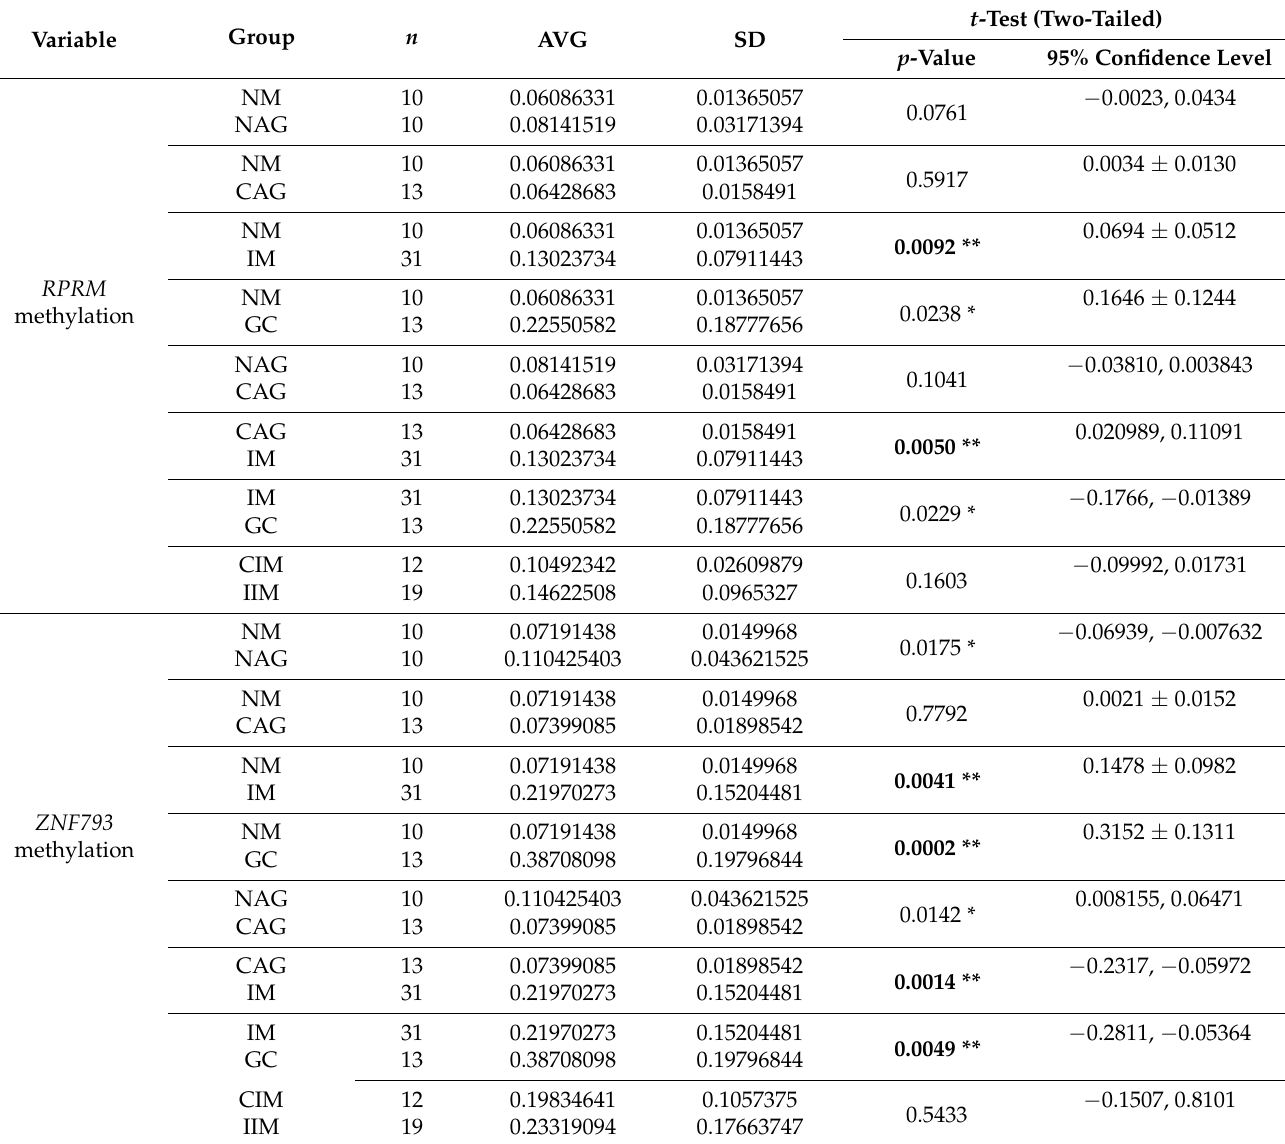
Table 1. Descriptive statistics and results of independent sample t -test for significance and comparisons between precursor lesions. * significant at p < 0.05, ** significant at p < 0.01. CAG, multifocal chronic atrophic gastritis; CIM, complete intestinal metaplasia; GC, gastric cancer; IIM, incomplete intestinal metaplasia; IM, intestinal metaplasia; NAG, non-atrophic gastritis; NM, normal